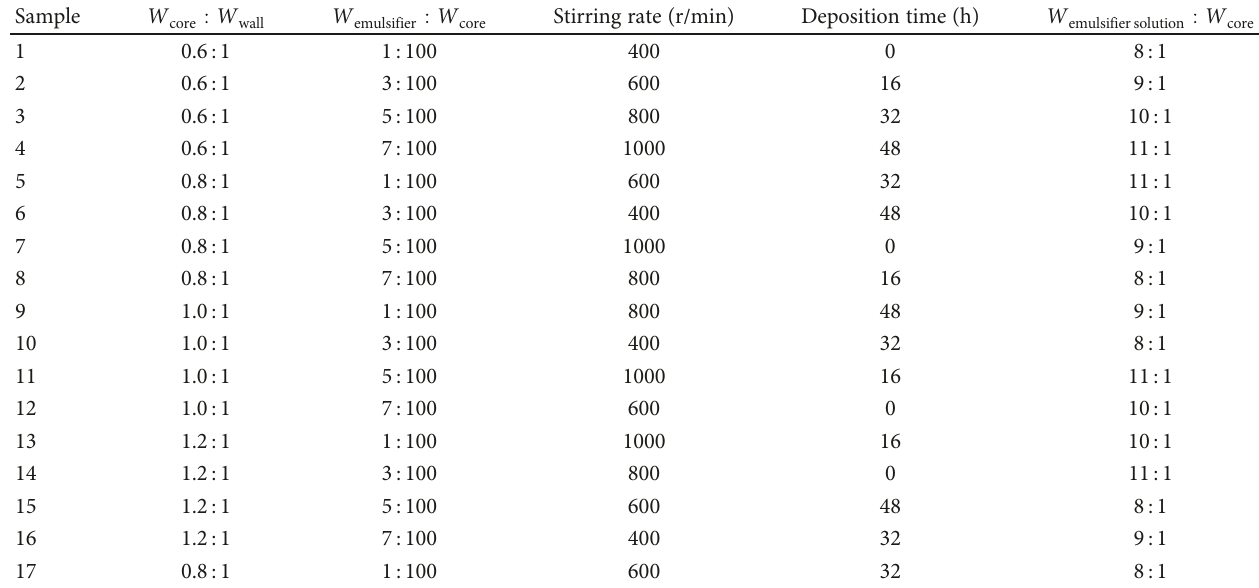
Table 2: Experimental arrangements.